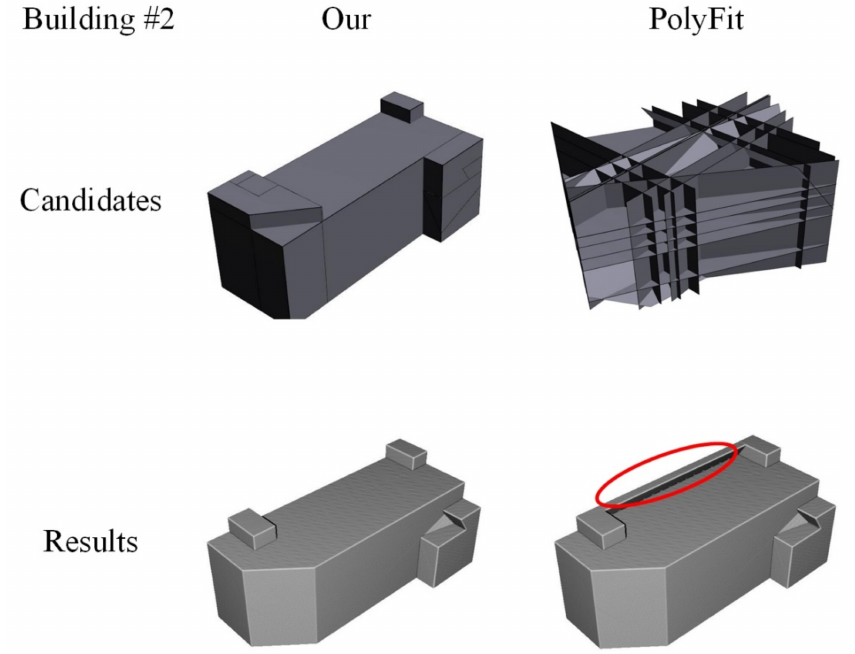
Figure 8. Comparison of candidate faces and resulting models generated by the proposed method and PolyFit [10] for Building